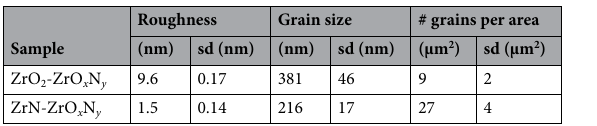
Table 2. Parameters characteristic the morphology of the films.